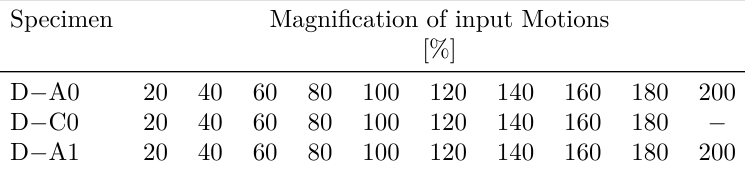
Table 3. Magnification of input wave in the shake table tests.